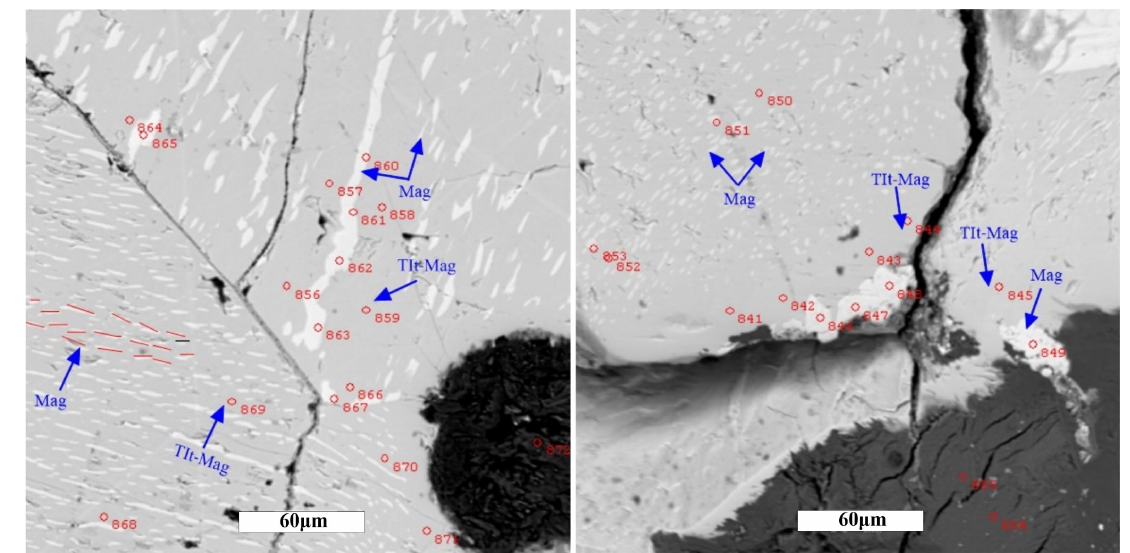
Figure 9. Back-scattered electron (BSE) images of iron titanium oxide intergrowth. Table 3. Representative electron microprobe analyses of ilmenite from the Abu Ghalaga mine, The analyzed ilmenite minerals of the Abu Ghalaga area nearly approach the ideal Egypt. composition, with TiO 2 ranging between 44.51 and 49. 07% (average 48.11%), and FeO t between 48 and 52.43% (average 49.51 wt.%). In addition, they have a small amount of MgO (0.87 to 1.9%), MnO (0.22–0.35 wt.%), Cr 2 O 3 (0.00–0.0.6 wt.%), Na 2 O (0.00–0.05 wt.%), CaO (0.00–0.05 wt.%), and Al 2 O 3 (0.00–0.26 wt.%) and trace amounts of SiO 2 and ZnO. The titano-magnetite minerals of the Abu Ghalaga area contain FeO t ranging between 76.38 and 88.59% (average 83.0%), and TiO 2 between 1.38 and 18.52% (av. 8.88%). They have a small amount of MgO (0.01 to 0.27%), MnO (0.00–0.05 wt.%), Cr 2 O 3 (0.30–0.67 wt.%), Na 2 O (0.00–0.05 wt.%), CaO (0.00–0.06 wt.%), and Al 2 O 3 (0.01–0.35 wt.%) and trace amounts of SiO 2 (0.00–0.79 wt.%) and ZnO (0.0–0.26%). In comparison to ilmenite, the titano-magnetite has high FeO content and a very low TiO 2 level (Table